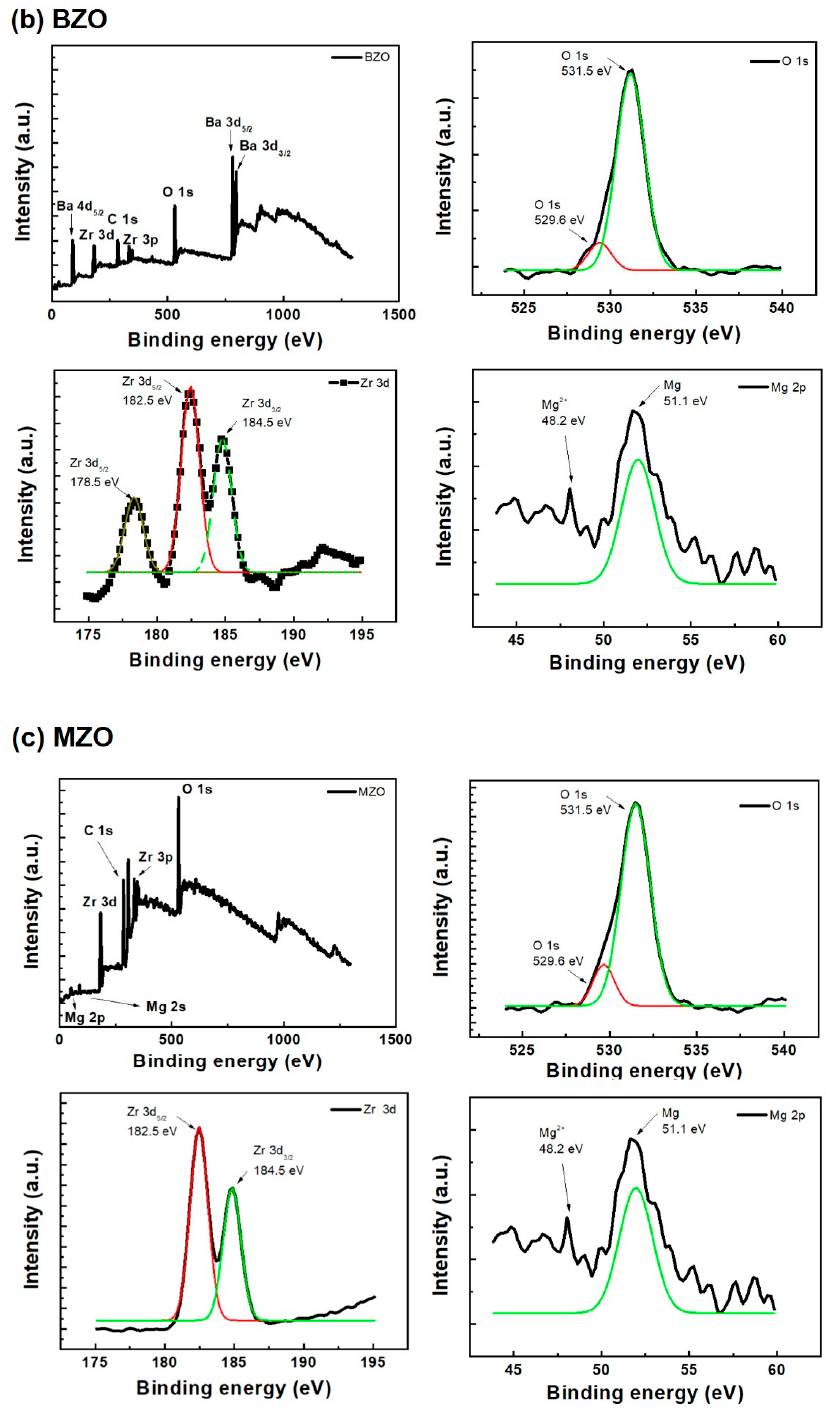
Figure 3. XPS full spectra of ( a ) SZO, ( b ) BZO, and ( c ) MZO thin films. The peaks for the O1s core level may be consistently fitted by two different near– Gaussian subpeaks centered at and 529.6 and 531.5 eV. The binding energy of lattice oxygen is 529.6 eV, which is attributed to the binding of O 2 ions to metal ions. The peak at 531.5 eV is associated with non-lattice oxygen source ions, such as oxygen vacancies. The devices were operated without a forming process because of the sufficient non–lattice oxygen ions in the SZO, BZO and the MZO thin films. According to the XPS results, the O vacancy /O lattice ratio, where O lattice refers to the lattice oxygen, can be considered as a criterion for